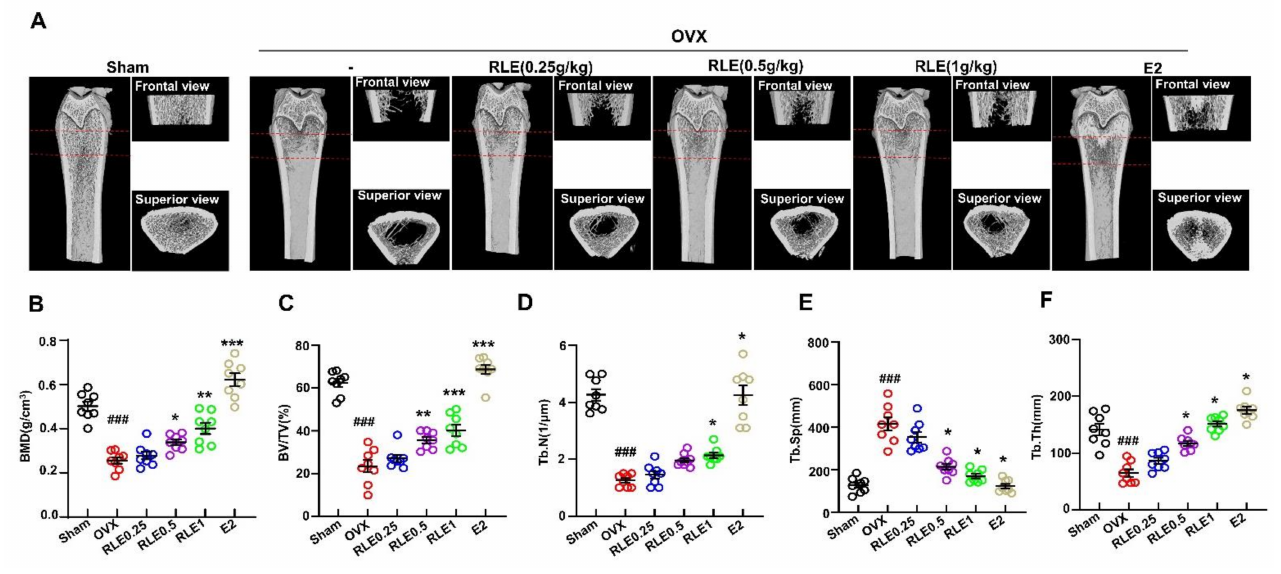
Figure 3. RLE prevents OVX-induced bone mass loss in rats. ( A ) Representative microCT images of the femur bone. ( B – F ) Bone structural characteristics such as bone mass density (BMD in g/cm 3 ), ratio of bone volume to total volume (BV/TV in %), trabecular number (Tb.N in 1/mm 2 ), Tb.Sp (mm), and trabecular thickness (Tb.Th) are shown. Data are shown as mean ± SEM. ( n = 10, ### p < 0.001 vs. sham; * p < 0.05 vs. OVX, ** p < 0.01 vs. OVX, *** p < 0.001 vs. OVX). Sham, sham-operated group; OVX, ovariectomy; RLE, Ramie leaf extract.